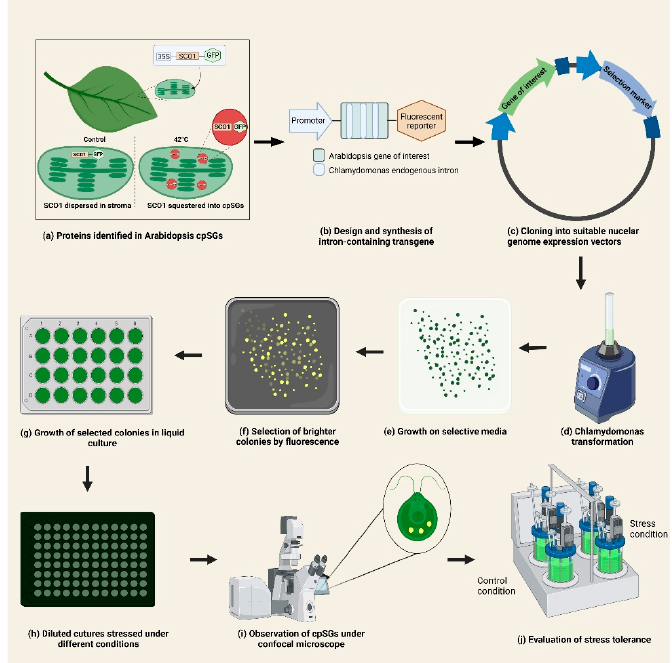
Figure 1. Proposed strategy for the integrated use of A. thaliana and C. reinhardtii in the study of plastid stress granules. ( a ) Selection of proteins localized into cpSGs in Arabidopsis identified by snowy cotyledon 1 (SCO1) as bait, [10]. ( b ) Selection of few candidate genes. Synthesis of their coding sequences considering codon optimization and the insertion of introns for proper expression in Chlamydomonas. ( c ) Cloning of synthesized sequences into suitable nuclear genome expression vectors (pOptimized or MoClo) [28,29]. ( d ) Transformation of C. reinhardtii and ( e ) growth on selective media. ( f ) Examination of positive colonies and selection based on the fluorescence of the tagged protein [31]. ( g ) Growth of selected colonies on liquid media and ( h ) dilution before stress treatment. ( i ) Evaluation of cpSGs formation by confocal microscopy [32] and ( j ) assessment of stress tolerance of transformed Chlamydomonas strains. Figure was prepared using BioRender.com